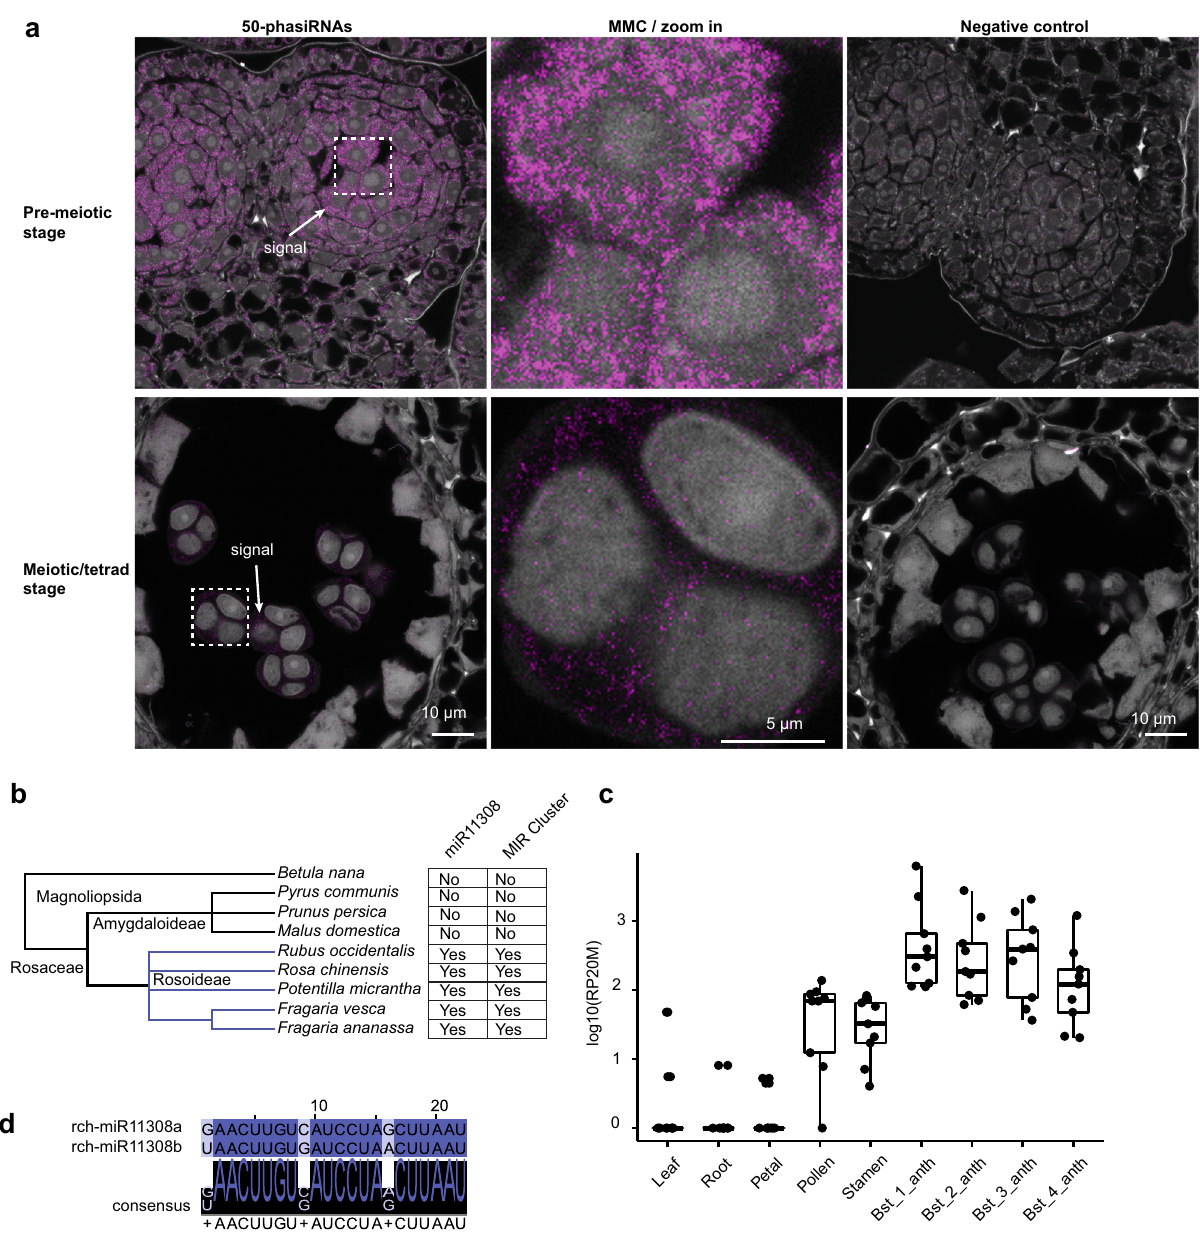
Fig. 3 The 21 nt reproductive phasiRNAs localize in all cell layers of the pre-meiotic strawberry anthers and the miR11308 trigger emerged in the Rosoideae. a Localization of abundant 50 21 nt reproductive phasiRNAs in pre-meiotic and meiotic anther tissues of wild strawberry. The localization experiment was repeated twice with similar results. b Phylogenetic tree showing conservation of miR11308 in the Rosaceae. c Abundances of summed 21 nt phasiRNAs in different tissues of rose in units of log10(RP20M). In the boxplot, the center line represents the median, box limits are the upper and lower quartiles; whiskers are the 1.5× interquartile range of upper or lower quartiles; points show the scatter of data points for nine ( n = 9) 21- PHAS loci. Bst indicates bud stage, anth indicates anther. d Alignment of members of miR11308 in rose. Source data underlying Fig. 3c are provided as a Source Data fi